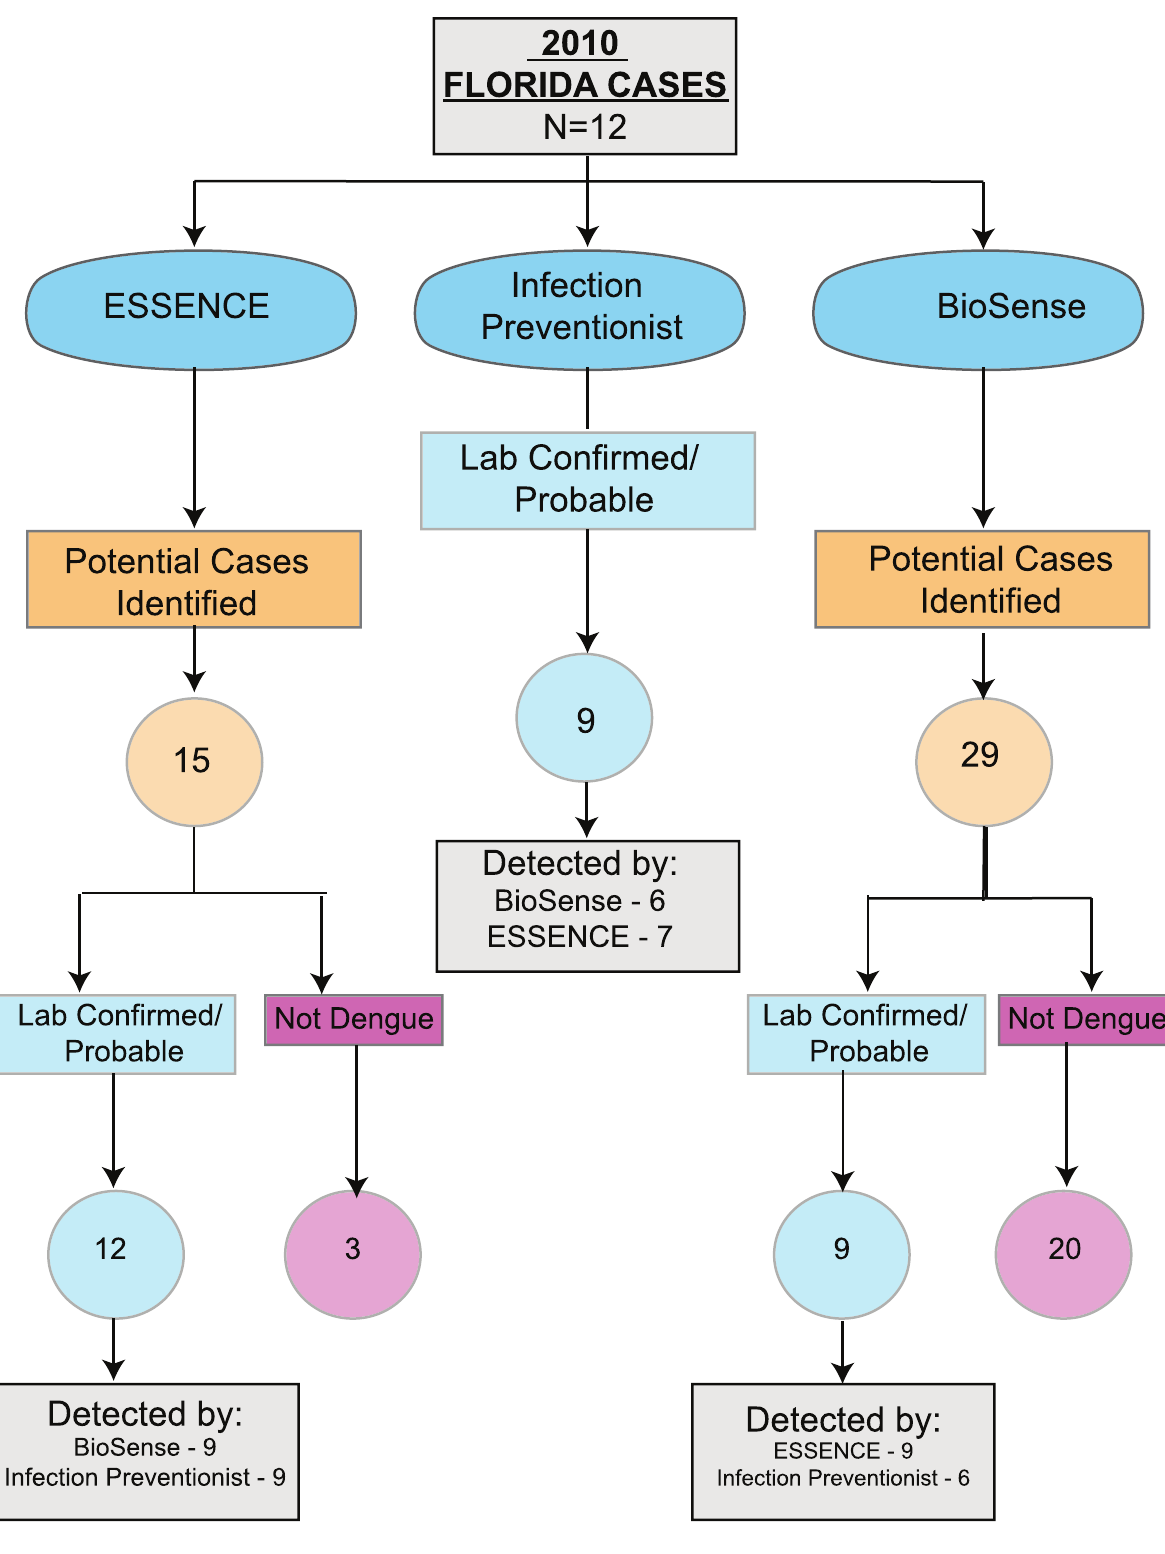
Figure 3. Comparison of electronic and manual surveillance case identification. Flow diagram of identification of 2010 Florida dengue confirmed/probable cases utilizing ESSENCE, infection preventionists, and BioSense.